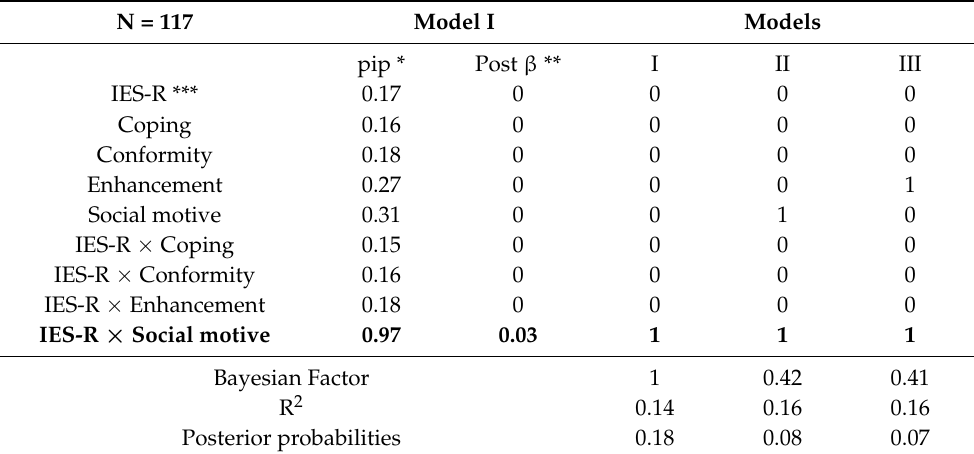
Table 3. Bayesian analyses for assessing the moderating effects of motives for using social media on the relationships between improvement of general distress symptoms after lockdown (the dependent variable) and COVID-19-pandemic-related post-traumatic stress